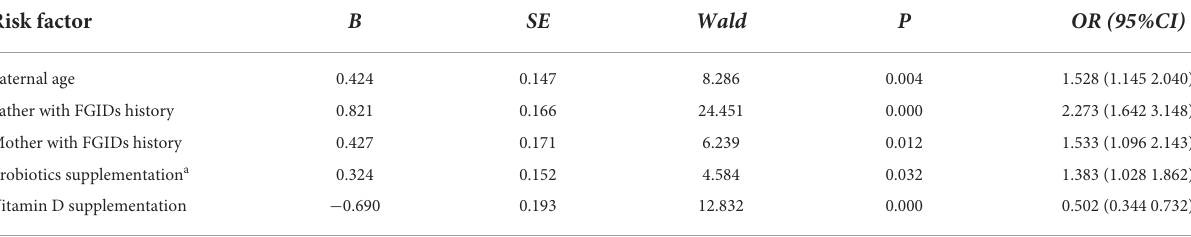
TABLE 4 The results of multiple factor unconditional logistic regression analysis on infant FGIDs.